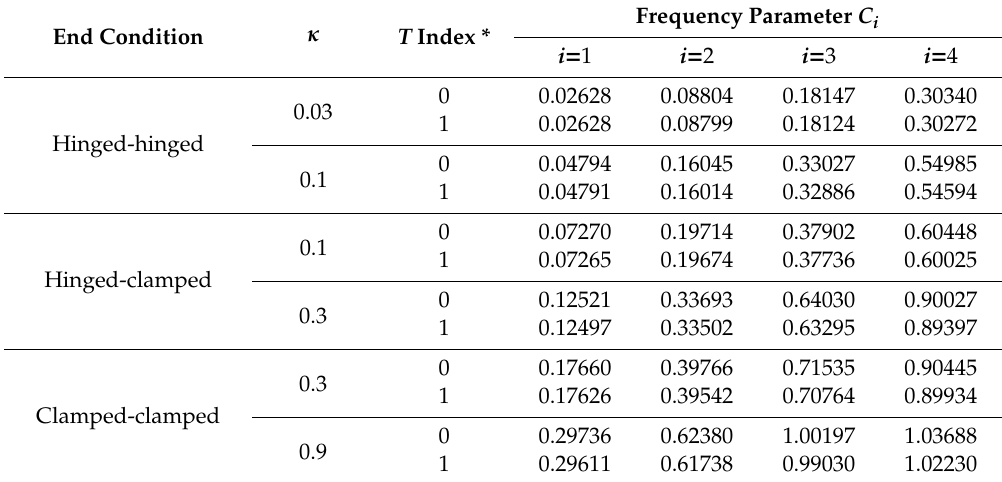
Table 2. E ff ect of rotatory inertia couple T on frequency parameter C i .